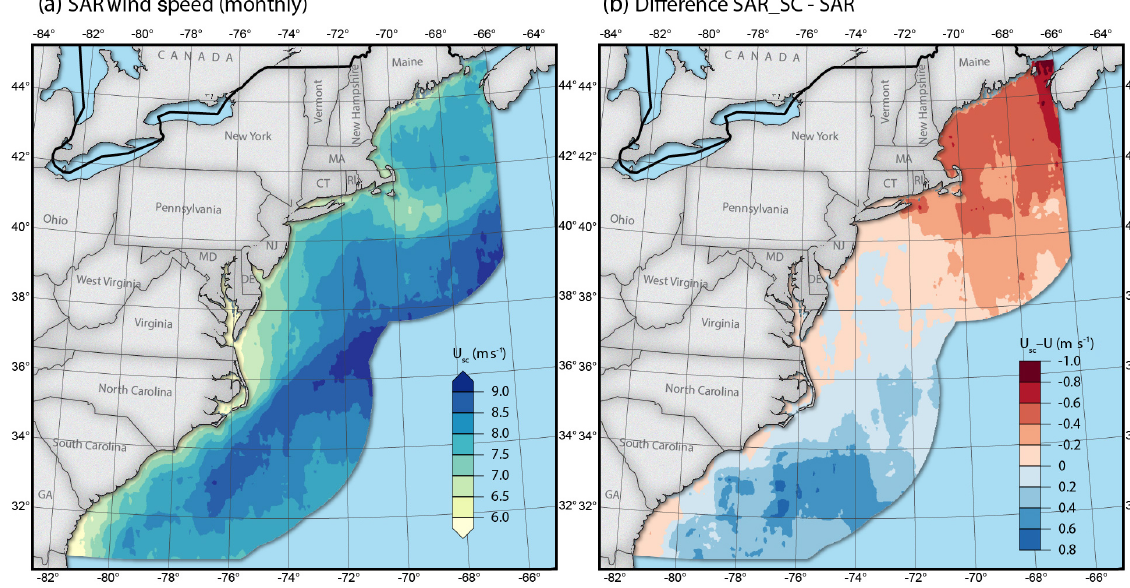
Figure 8. (a) Seasonally corrected SAR wind speed; (b) difference between seasonally corrected and original SAR